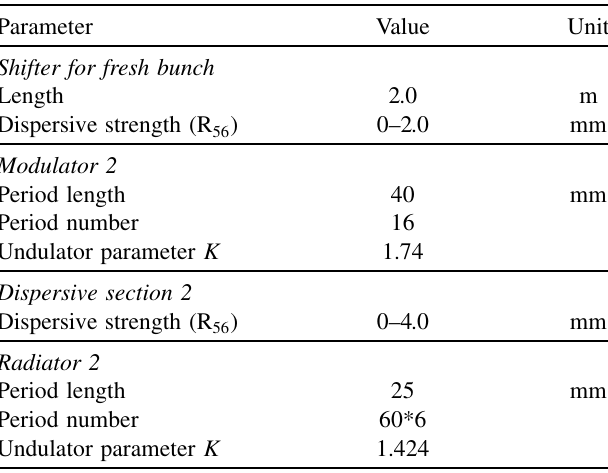
TABLE III. Main parameters of the second stage.